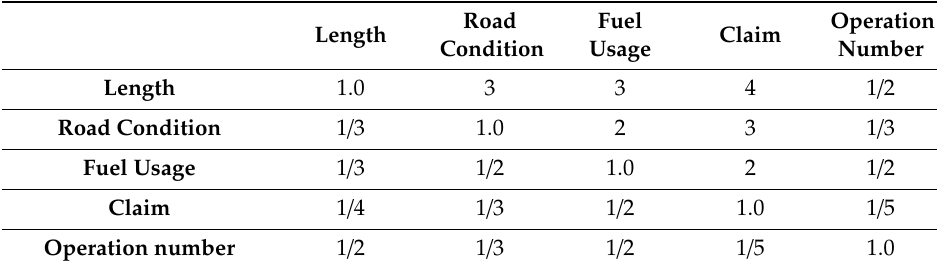
Table 2. Importance of Cost Elements Pairwise Contrast.